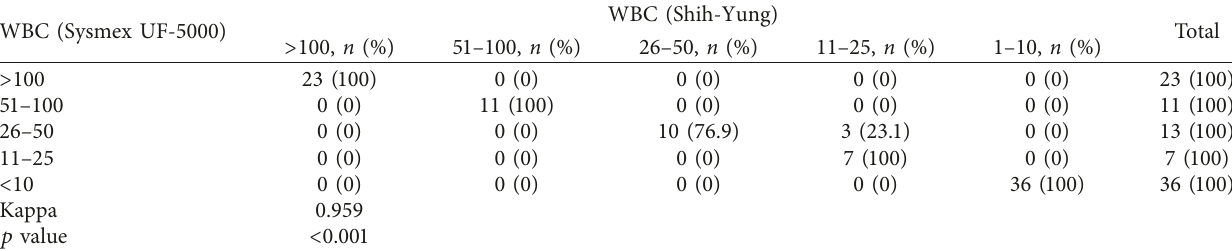
Table 2: Cross-tabulation and a kappa value of Sysmex UF-5000 and Shih-Yung (leukocyte parameter).